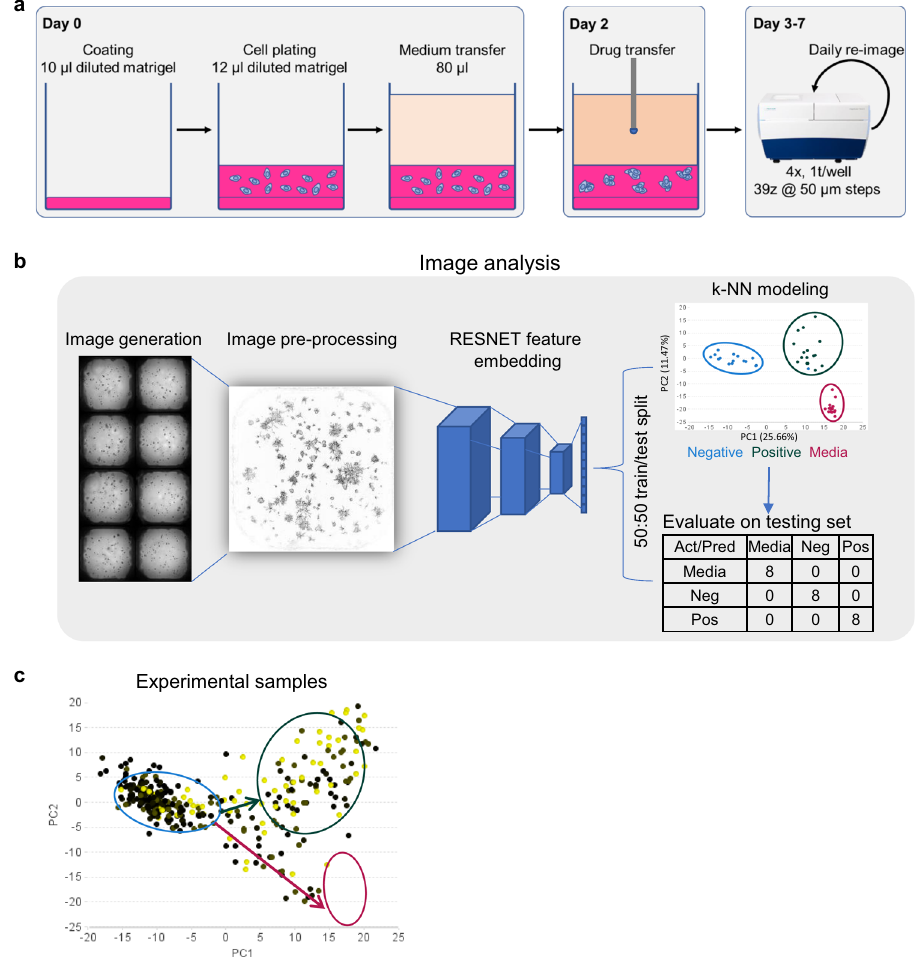
Fig. 2 3D organoid cultures and the development of RESNET. a Schematic diagram of organoid cultures and screening work fl ow. Plates are generated by fi rst depositing a buffer layer of 60% Matrigel to prevent cells from adhering to the bottom. Cell-containing 50% Matrigel is then added followed by media. Drugs are transferred using a 100 nl pin tool 2 days after cell seeding and serial bright- fi eld imaging is performed in the following days. b Image analysis pipeline. 3D image stacks are fi rst background corrected and projected into a single z-plane. High-level image features are then derived from the fl attening layer of the RESNET-18 pre-trained on the ImageNet dataset. Principal component analysis is then used to explore response patterns (the percent of variance that is explained by each principal component is labeled to the axis) and k-nearest neighbor model is constructed for subsequent classi fi cation tasks. Assay quality is monitored using a 50/50 train/test split for each control category, which is shown in the confusion matrix. Negative (Neg), DMSO- treated wells; Positive (Pos), miR-200c induced wells; Media, cell-free wells. Act/Pred, Actual vs Predicted. c Principal component analysis of RESNET-18 features for experimental samples with control regions annotated (blue, negative region; dark green, positive region; red, media region). Increasing drug concentrations are shown from low (black) to high